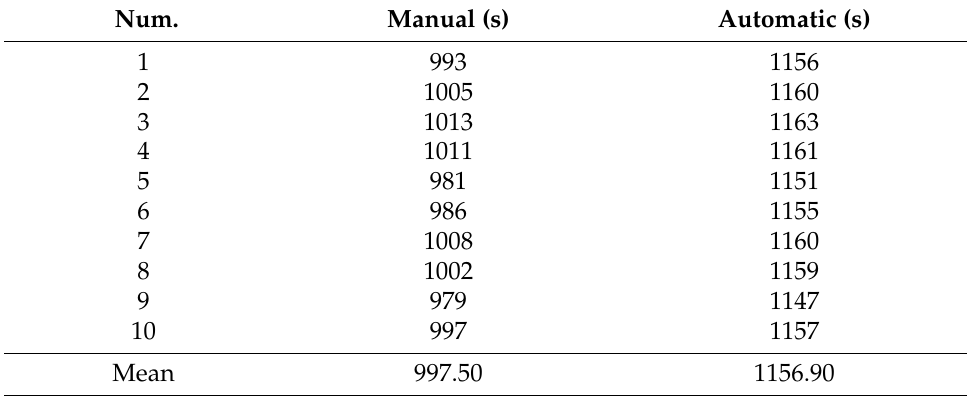
Figure 27. Garbage collection with the autonomous vehicle. Table 1. Garbage collection